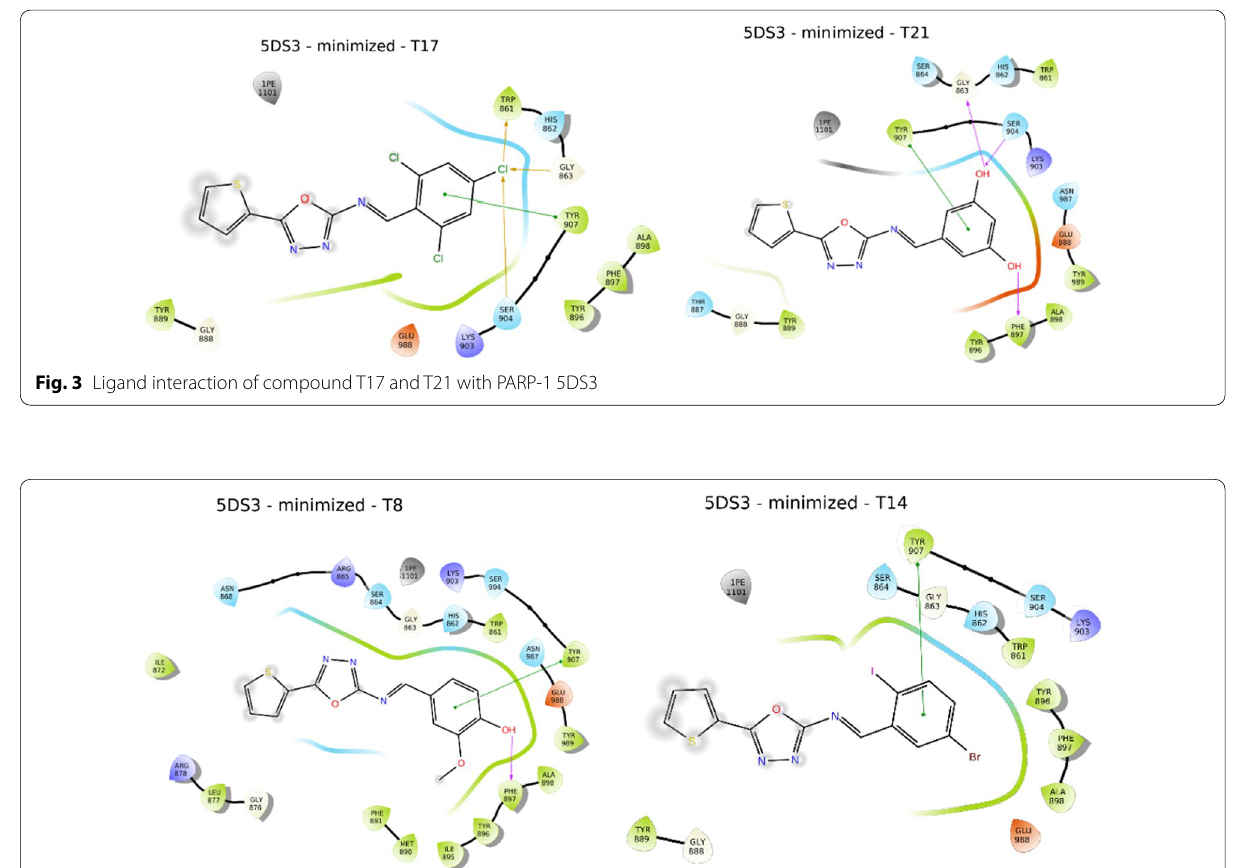
Fig. 4 Ligand interaction of compound T8 and T14 with PARP-1 5DS3